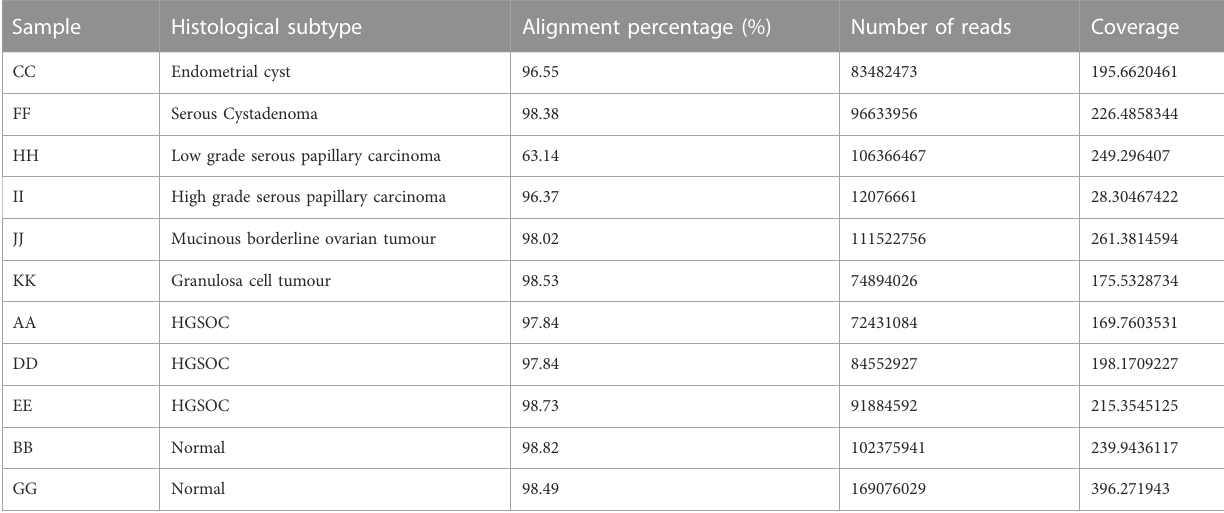
TABLE 3 Transcriptome sample